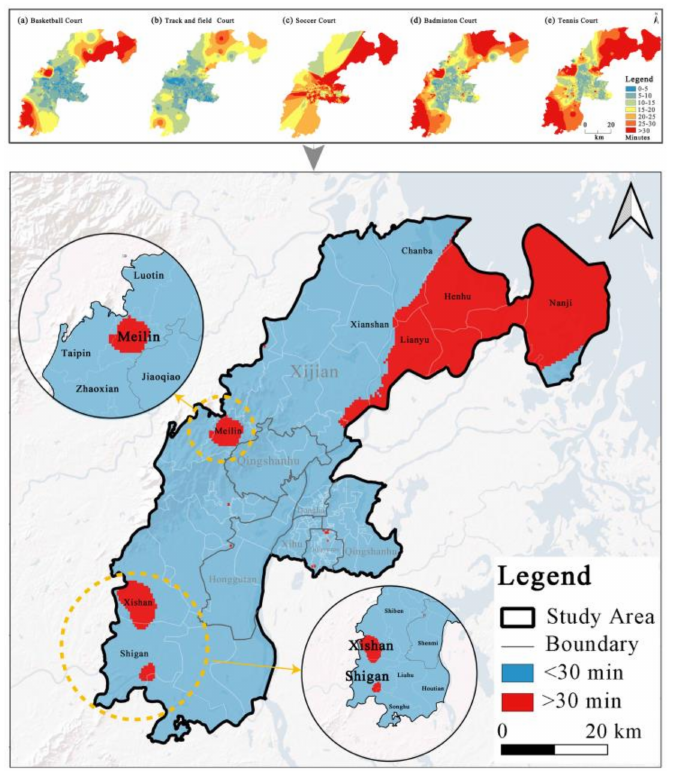
Figure 19. The averaged accessibility based on the results of the five types of outdoor sports